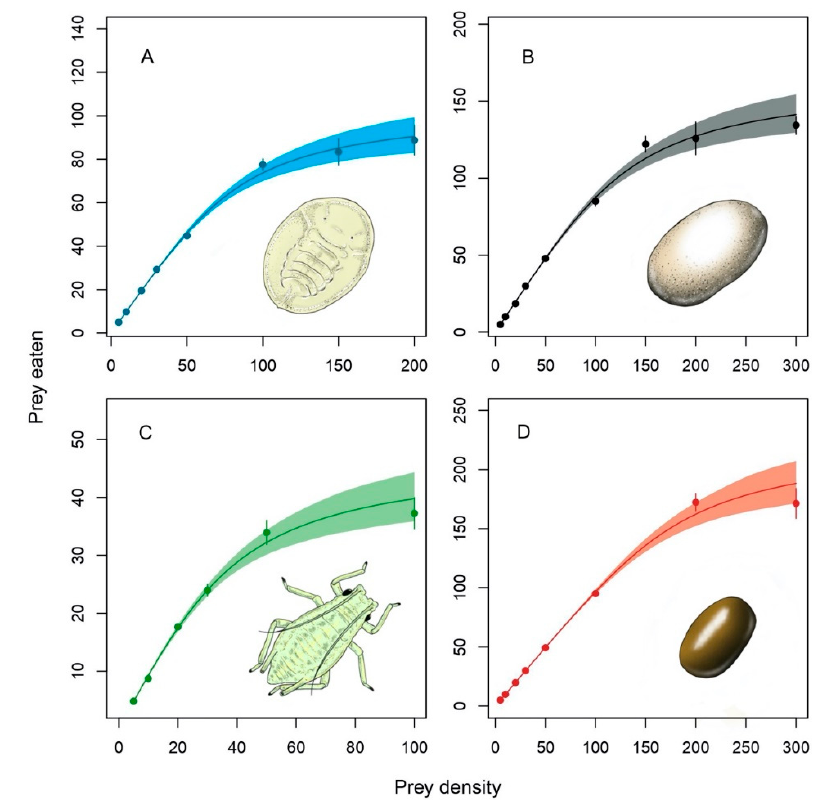
Figure 2. Functional response curves of Dicyphus cerastii females when preying on Bemisia tabaci 4th instar nymphs ( A ), Ephestia kuehniella eggs ( B ), Myzus persicae 1st instar nymphs ( C ) and Tuta absoluta eggs ( D ). Dots represent the average consumption and bars the respective standard error. Shaded areas represent bootstrapped 95% confidence intervals. Note that vertical and horizontal axis scales are not the same among prey species.